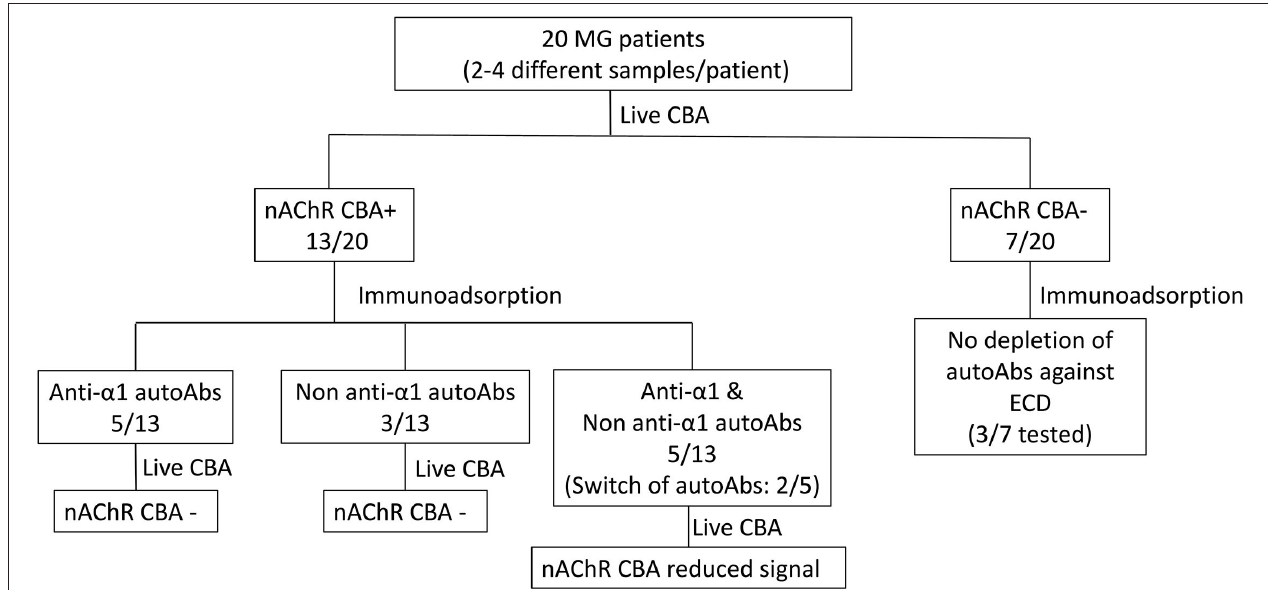
FIGURE 1 | Specificity of the autoAbs derived from patients with myasthenia gravis (MG). Overview of the results.